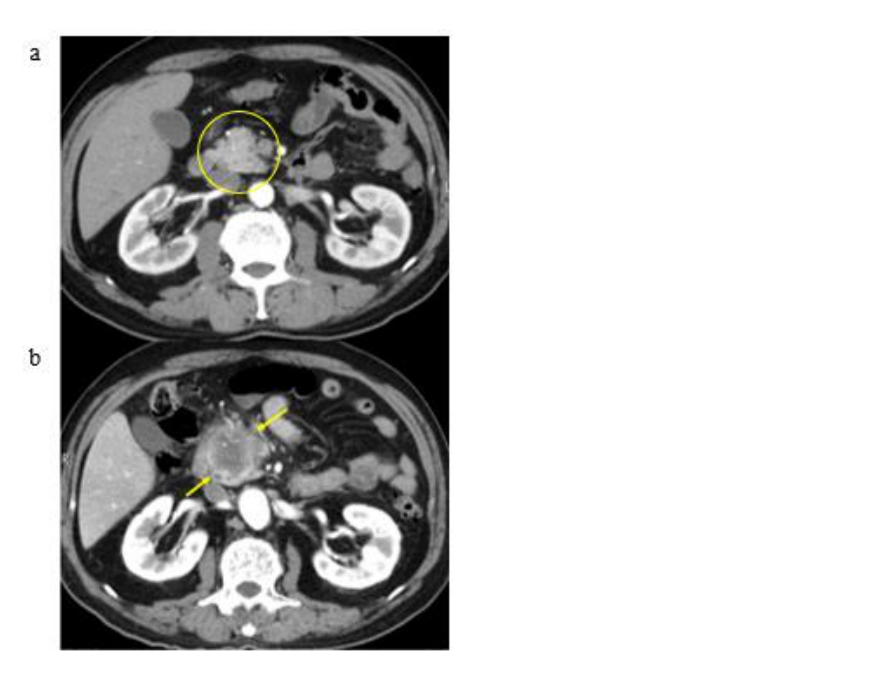
Figure 5. ( A ) Group B (a representative patient with localized fatty change in the pancreatic head): ( a ) July 2006: pancreatic head looks normal on this CT (a yellow circle); ( b ) April 2013: localized fatty change is shown in the pancreatic head (a yellow circle); ( c ) October 2014: pancreatic head cancer is shown at the site of localized fatty change (a yellow circle). ( B ) Group B (a representative patient with localized fatty change in the pancreatic uncinate): ( a ) August 2014: localized fatty change is shown in the pancreatic uncinate (a yellow circle); ( b ) July 2016: localized fatty change expanded compared with the previous CT in 2014 (a yellow circle); ( c ) January 2017: pancreatic uncinate cancer is shown at the site of localized fatty change (a yellow circle).